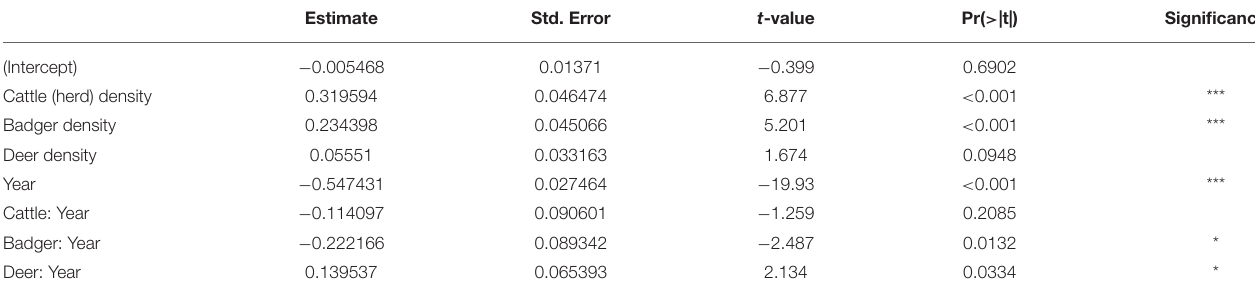
TABLE 1 | Output from the GLM of herd-level analysis. Estimate Std.